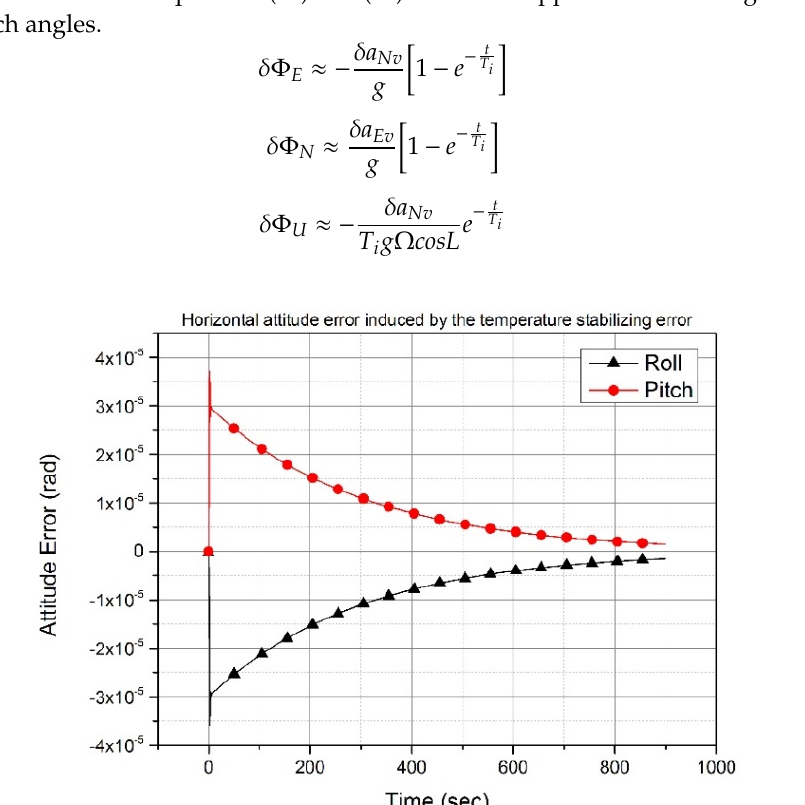
Figure 5. Horizontal attitude error induced by the temperature stabilizing error. Roll and pitch errors decrease exponentially.